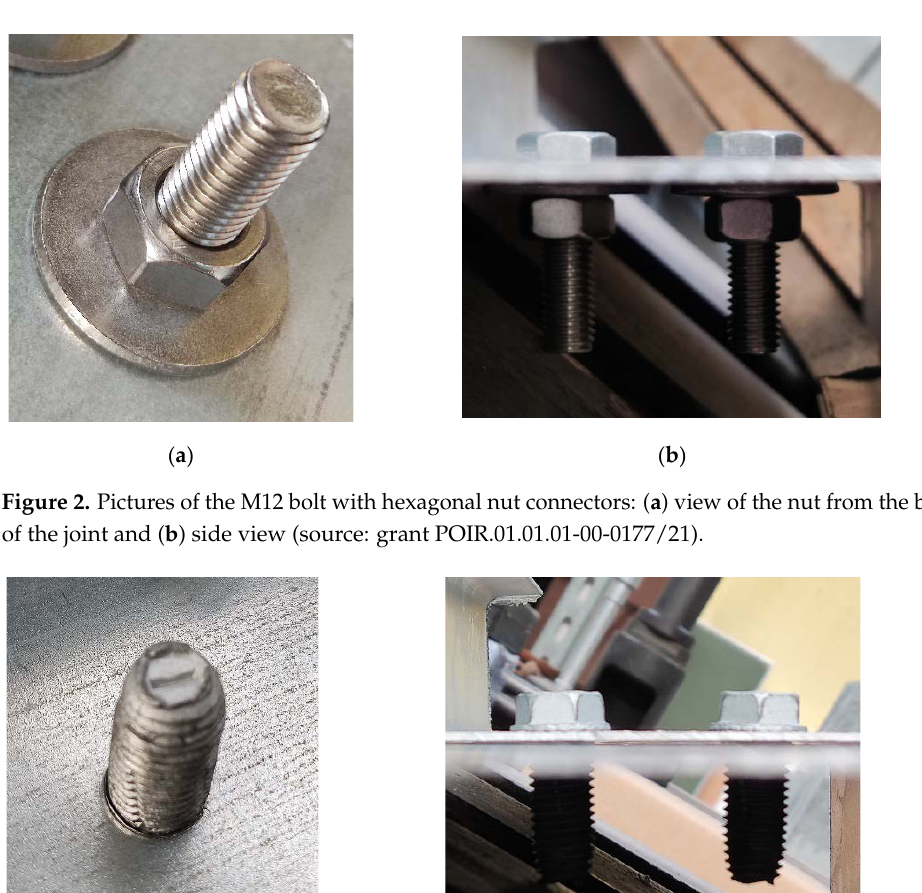
Figure 1. ( a ) An example of a substructure for photovoltaic panels made of thin-walled cross-sec- tions with typical bolt connectors; ( b ) magnified bolt connector with a nut (source: grant POIR.01.01.01-00-0177/21).